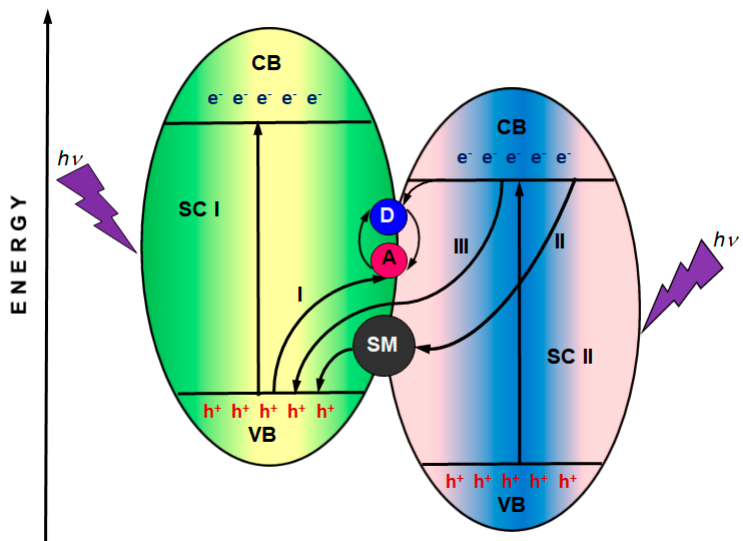
Figure 6. A schematic illustration of different types of Z-scheme heterojunctions: I—Z-scheme with a redox pair mediator; II—Z-scheme with a solid mediator; and III—direct Z-scheme. SC—semiconductor; D—donor; A—acceptor; and SM—solid mediator.